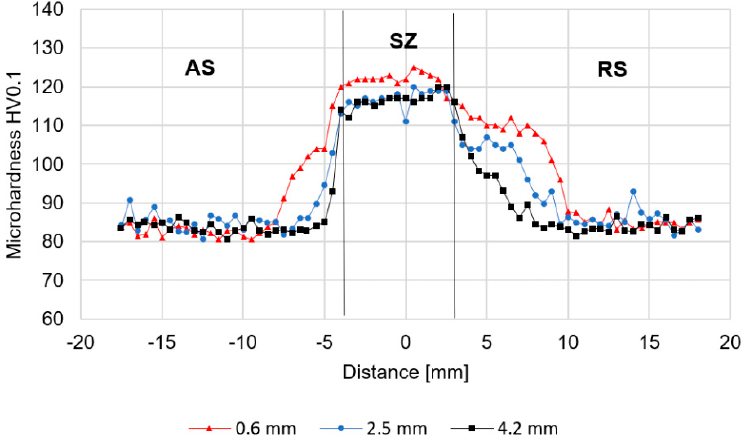
Figure 11. Distribution of microhardness in the A81 sample with respect to the distance from the top of the joint.